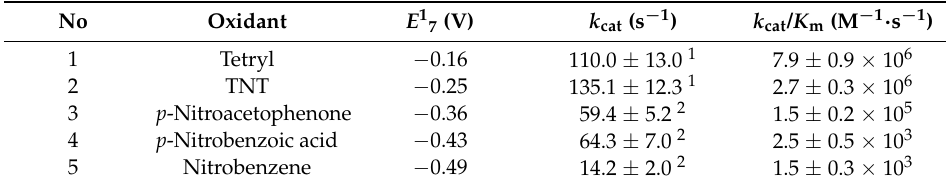
Table 1. The single-electron reduction potentials ( E 1 7 ) of nitroaromatic compounds and the steady-state rate constants of their reduction by NfsA